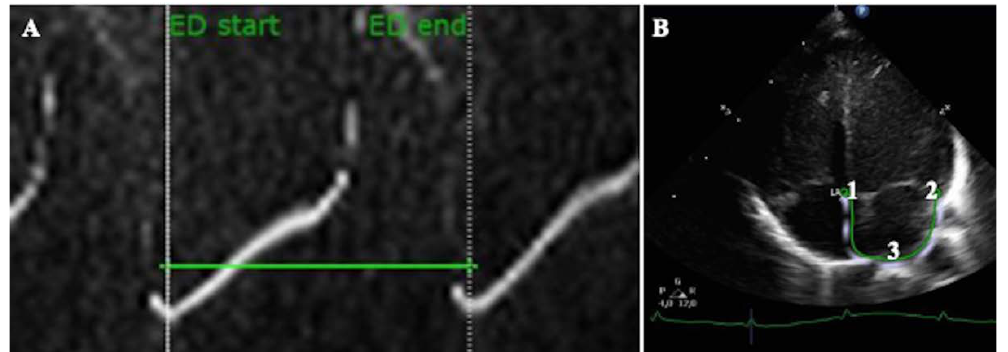
Figure A1. ( A ) M-mode display of the motion of the anterior leaflet of the mitral valve. End-diastole is defined at the mitral valve closure. ( B ) Three-points for left atrial delineation: points 1 and 2 at the septal and lateral hinge points of the mitral valve and point 3 at the atrial roof.